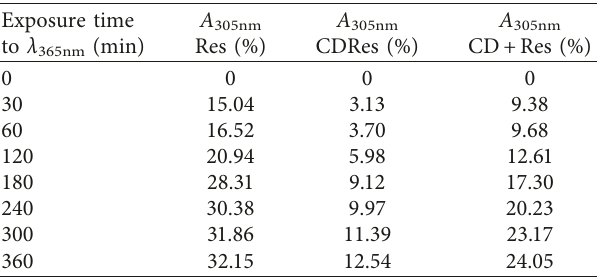
Table 2: Degradation percentages at 305nm of resveratrol (Res), CDRes, and inclusion complex of CM- β -CD with Res after ex- posure to UV radiation at